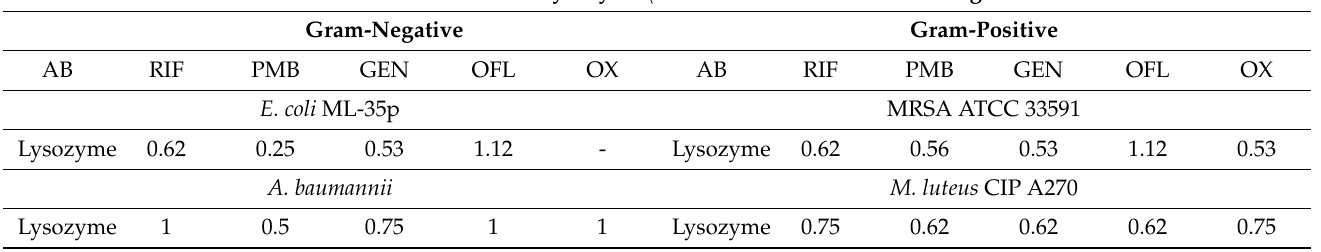
Table 4. Antimicrobial activity of combinations of lysozyme with antibiotics against Gram-negative and Gram-positive